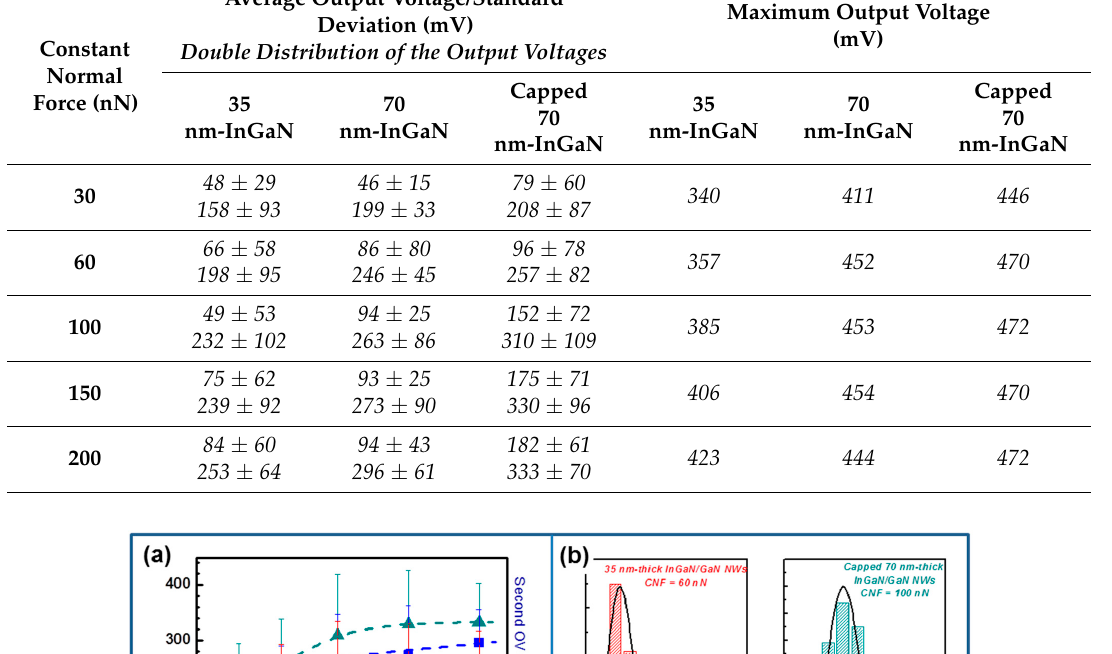
Table 1. Average values, standard deviations and maximal output voltages (with a measurement precision of 2%) generated by NWs as a function of the constant normal force.